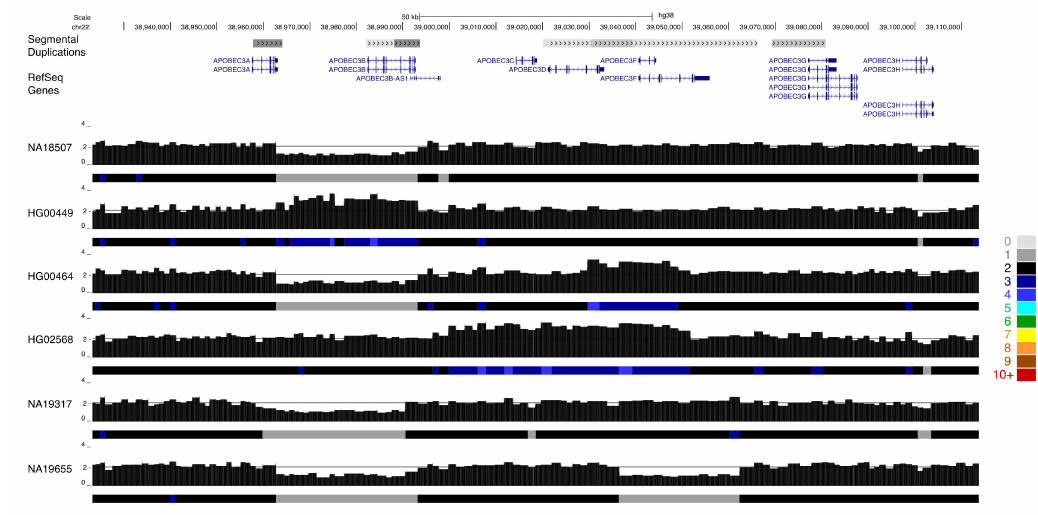
Figure 5. Rare copy number variation at the APOBEC3 locus analysis of 2457 individuals identified as having experienced rare gene gain losses at the APOBEC3 locus on chr22. Paralog specific copy number profiles are shown for six individuals. Samples NA18507 and NA19317 are heterozygous for the common APOBEC3A / B gene deletion polymorphism, but are predicted to carry two copies of the other APOBEC3 genes. A duplication of the APOBEC3A / 3B segment is present in sample HG00449. Sample HG00464 carries the common APOBEC3A / 3B deletion as well as duplication of a portion of APOBEC3F , while sample NA19655 has the common APOBEC3A / 3B deletion as well as apparent deletion of APOBEC3F . Individual HG02568 carries an extended duplication the includes APOBEC3C , APOBEC3D , and APOBEC3F